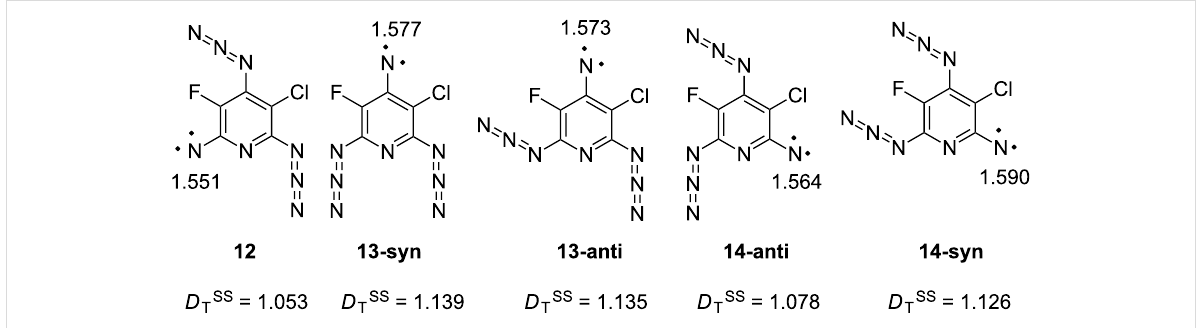
Figure 3: Mulliken spin populations on the nitrene units and parameters D TSS in cm − 1 of triplet nitrenes 12 – 14 at the PBE/DZ level of theory.